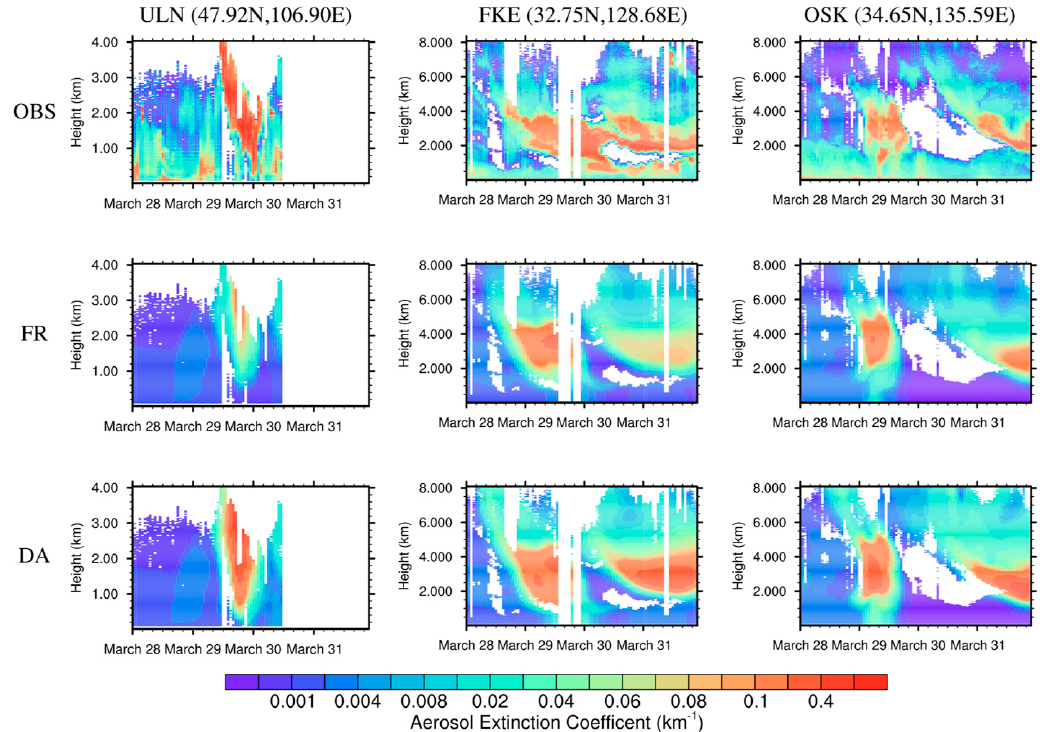
Figure 8. Comparisons of observed dust aerosol extinction coefficients from AD-Net and simulated ones for FR and DA experiments from 28 to 31 March 2018 at three selected sites (ULN: Ulaanbaatar; FKE: Fukue; OSK: Osaka). 5. Discussion To generalize this study, two additional experiments with the same configurations as before were further conducted from 1 to 3 April 2018 to investigate the effects of GCOM-C AOT assimilation on simulated aerosol optical properties. Figure S2 shows the simulated AOTs in the FR and DA experiments and their differences from 1 to 3 April 2018. Both simulated total AOTs and dust AOTs in the DA experiment were higher than